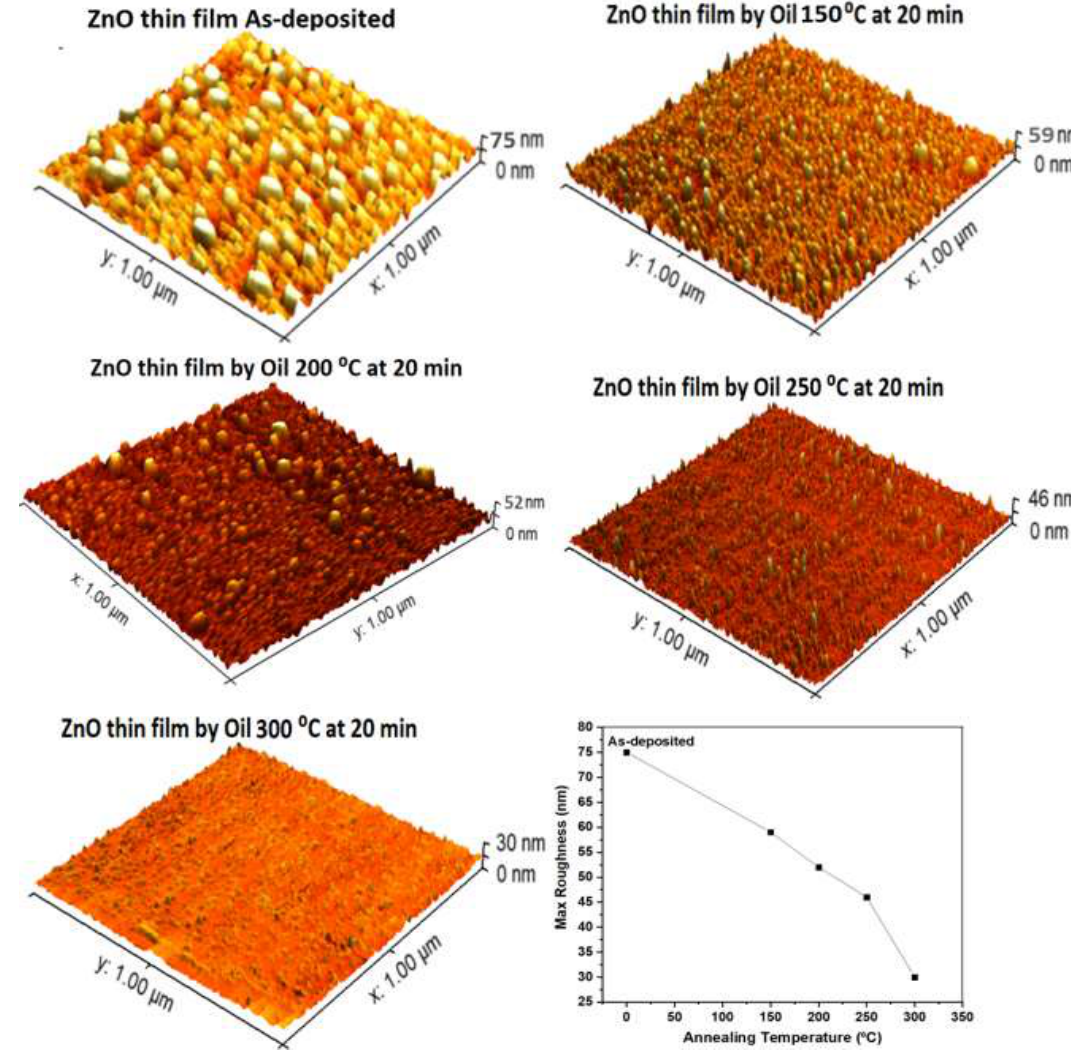
Figure 4: AFM images of the ZnO thin film before and after treatment by the OTA